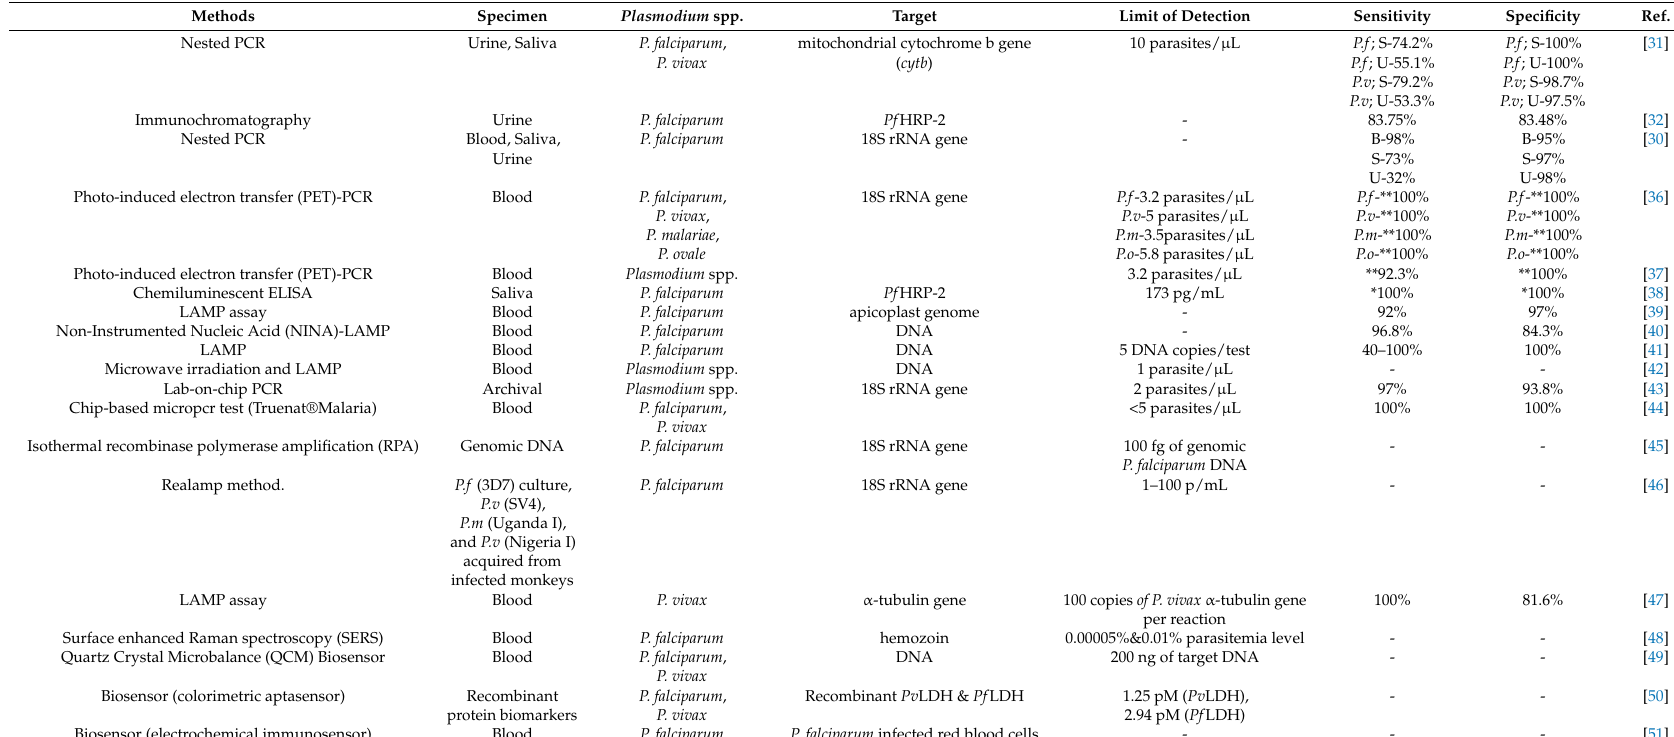
Table 2. Comparison of the analytical sensing parameters of molecular approaches developed for the diagnosis of